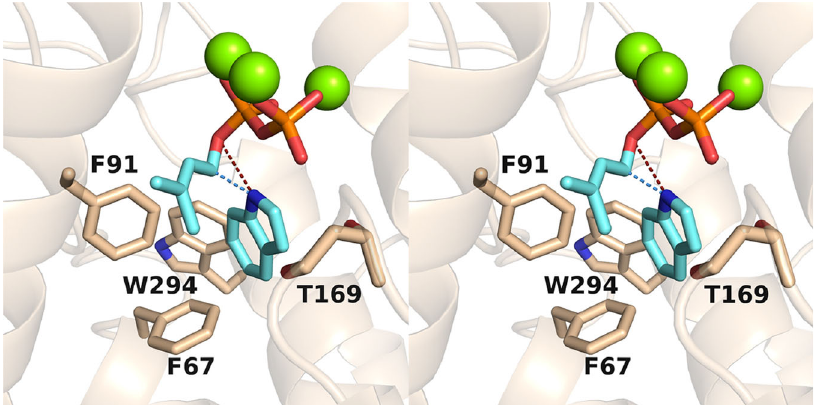
Fig. 6 Model of the FgGS – Mg 2 + 3 – DMAPP – indole complex. In this stereoview, the position of the diphosphate group of DMAPP corresponds to the experimentally observed position of the PP i group, and the position of the 5-membered ring of indole corresponds to experimentally observed position of the imidazole group in Fig. 5b. A light blue dashed line indicates the trajectory of bond formation between C1 of DMAPP and N1 of indole. If indole were fl ipped, this trajectory would correspond to bond formation between C1 of DMAPP and C3 of indole. A dark red dashed line indicates the most probable fate of the indole proton ultimately abstracted by co-product inorganic